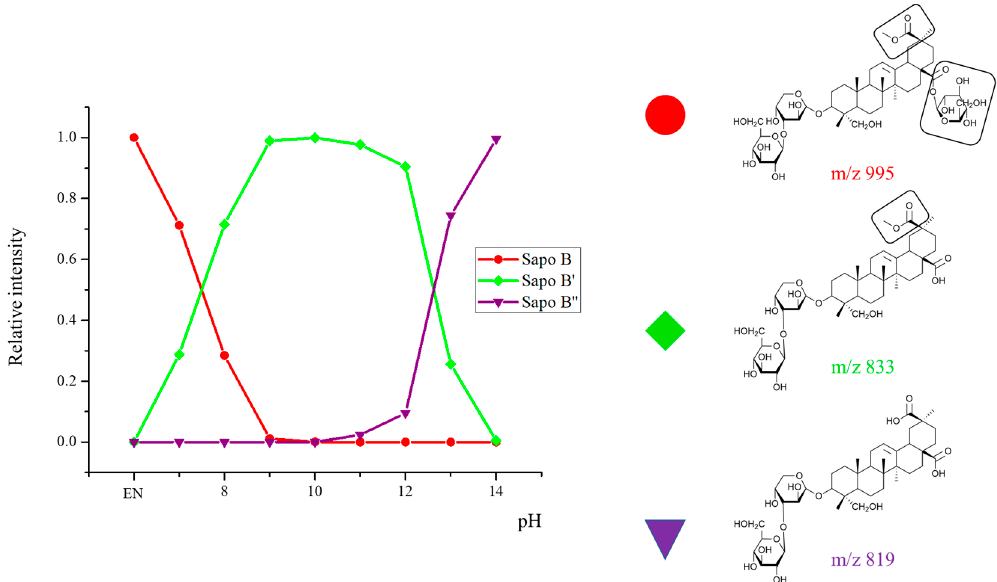
Figure 7. Microwave-assisted hydrolysis of the quinoa bidesmosidic saponins (5 min at 150 °C): influence of the pH on the extent of the consecutive hydrolysis reactions from Saponin B as determined using LC-MS. The given m / z ratios correspond to the [M + Na] + ions, but for the estimation of the relative proportions, both the [M + H] + and the [M + Na] + ions have been considered.